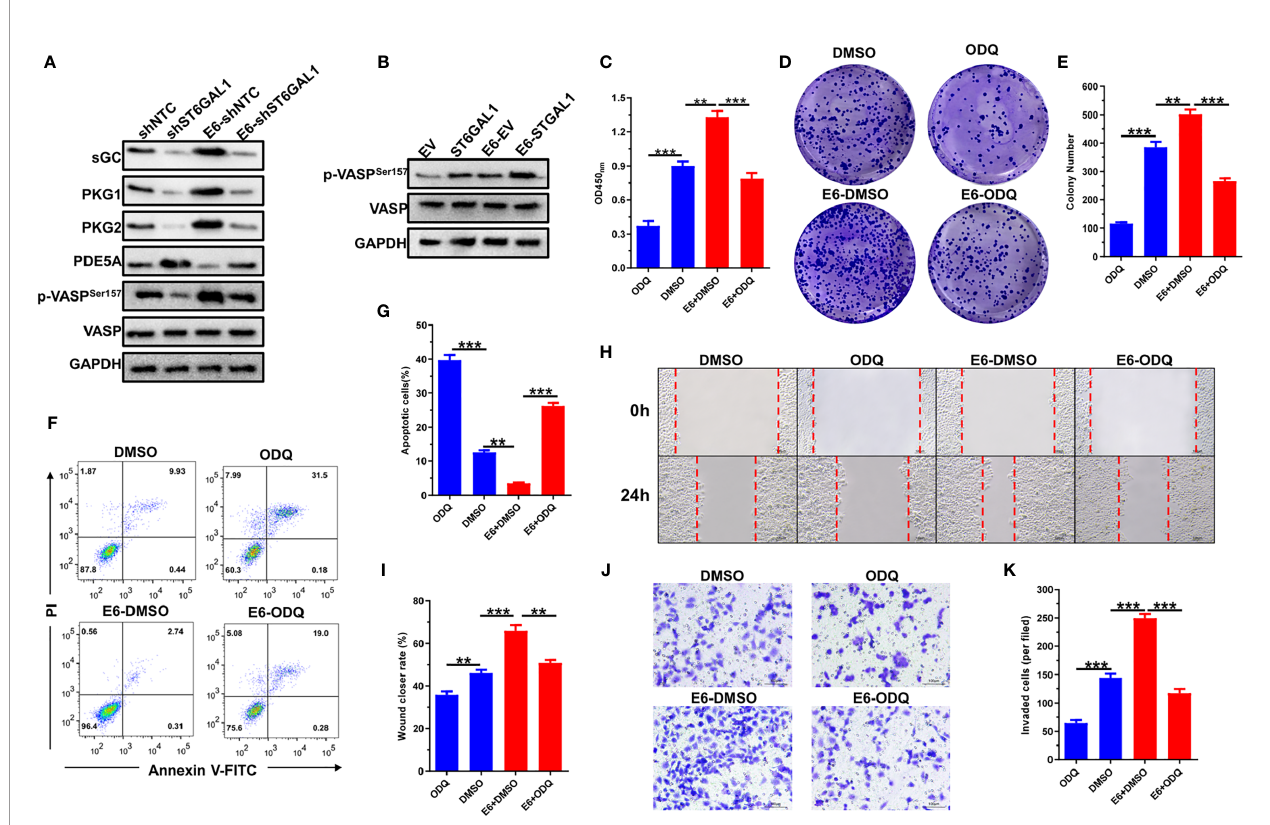
FIGURE 6 | HPV16 E6 activates cGMP/PKG signaling pathway through ST6GAL1. (A) C33A and C33A-E6 (E6 stable expressing) cells were transiently transfected with short hairpin RNA targeting ST6GAL1 (shST6GAL1) or a non-targeting control (shNTC). Forty-eight hours later, the expression of cGMP/PKG signaling pathway- related proteins were detected by Western blot. (B) C33A and C33A-E6 cells were transiently transfected with pcDNA3.1-ST6GAL1 overexpressing plasmid (ST6GAL1) or empty vector (EV). Forty-eight hours later, phosphorylated VASP expression in indicated cells were detected by Western blot. (C) Proliferation of indicated cells were detected by CCK-8 assay. (D) The clones of indicated cells were visualized by crystal violet staining. (E) Statistical analysis of colony numbers in indicated cells. (F, G) Apoptosis of indicated cells were detected by fl ow cytometry, and then, apoptotic rates were statistically analyzed. (H, I) Migrative abilities of indicated cells were detected by wound-healing assay and statistically analyzed. (J, K) Invasive abilities of indicated cells were detected by Transwell assay and statistically analyzed. Data were presented as mean ± SD from the three independent replicates. ** p < 0.01; *** p <